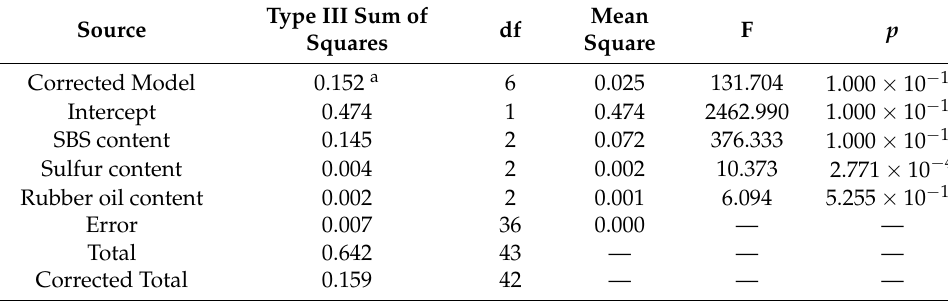
Table 5. Inter-subject effect test of three factors.